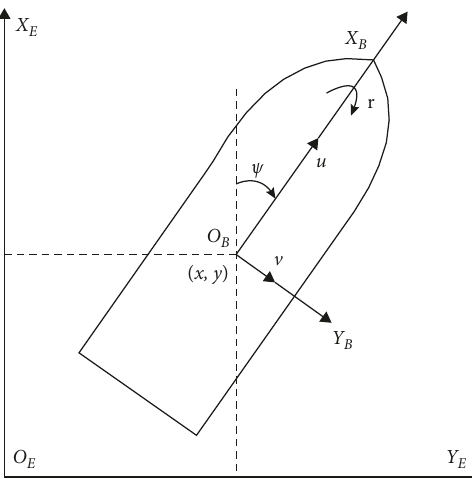
Figure 1: Earth-fixed frame and body-fixed